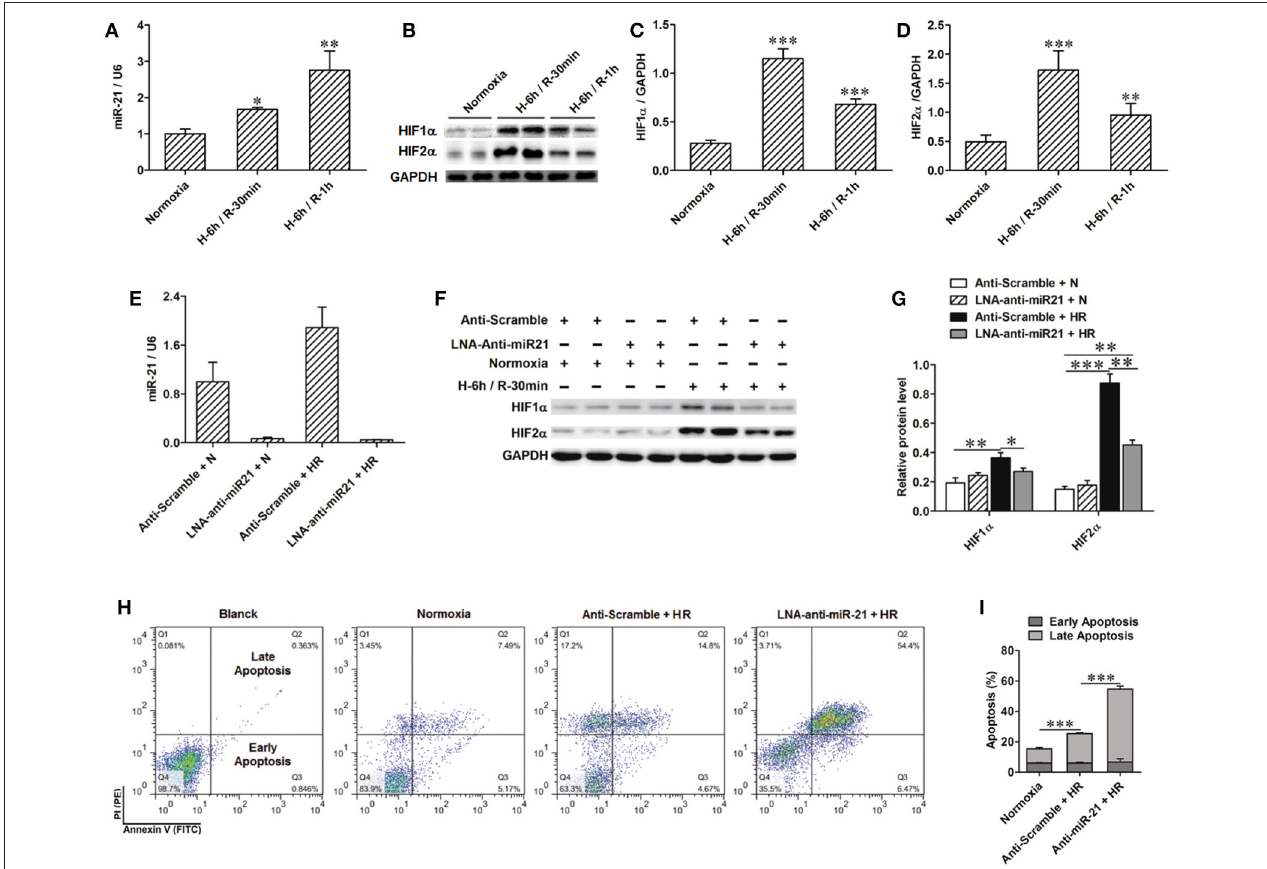
FIGURE 4 | Anti-miR21 attenuated HR induced up-regulation of HIF-1 α and HIF-2 α and aggravated HR induced apoptosis of HK-2. Expression of miR-21, HIF-1 α and HIF-2 α in the HK-2 cells under hypoxia (6h)/ reoxygenation (30min or 1h) condition were detected. (A) expression level of miR-21 in the HK-2 cells was increased from 30min after reoxygenation compared with normoxia condition. (B) Protein level of HIF-1 α and HIF-2 α were also elevated in the HR-treated HK-2 cells. (C,D) group data from F , n = 6, * p < 0.05, ** p < 0.01, *** p < 0.01 compared with normoxia condition. (E) Transfection of 50nM LNA-modified anti-miR-21 to HK-2 cells significantly inhibited expression of miR-21 even under normoxia or HR condition. (F) Inhibition of miR-21 attenuated HR induced up-regulation of HIF-1 α and HIF-2 α . (G) Group data from F. * p < 0.05, ** p < 0.01, *** p < 0.01, n = 6. (H) Apoptosis of the HK-2 cells was accessed by annexin-V-FITC/PI staining and determined by flow cytometry. Knockdown of miR-21 attenuated HR induced apoptosis of HK-2 cells. (I) Group data from (H) . *** < 0.001, n =